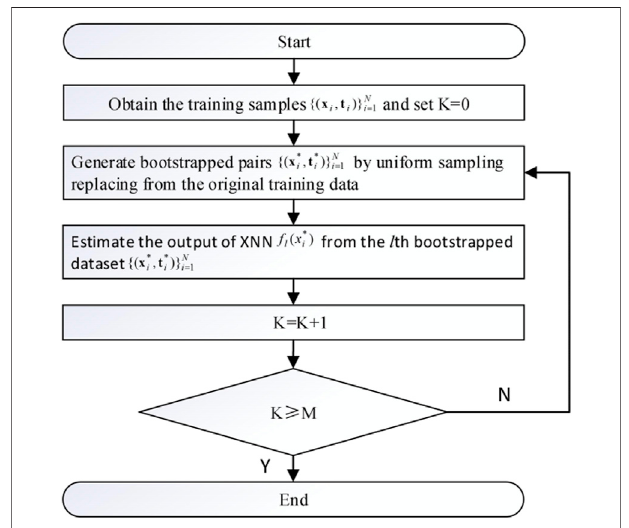
FIGURE 2 | Flowchart of Pairs bootstrap based on